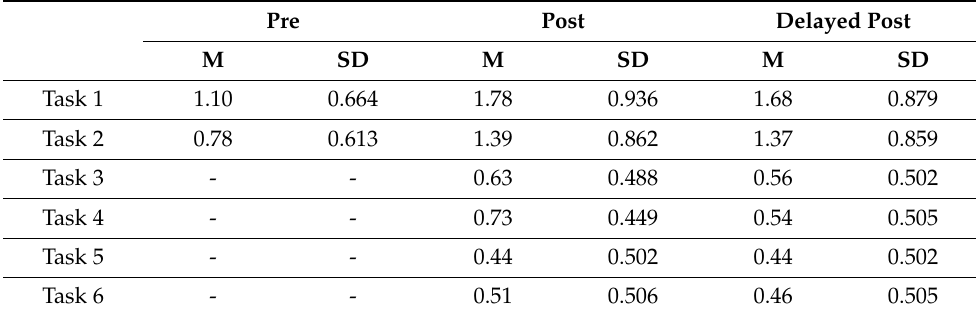
Table 2. Means and Standard Deviations of the students’ responses in the six Tasks ( n = 41). Pre